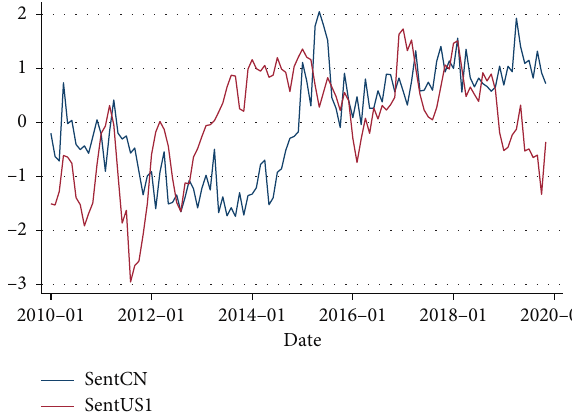
Figure 1: The United States and China investor sentiment (investor